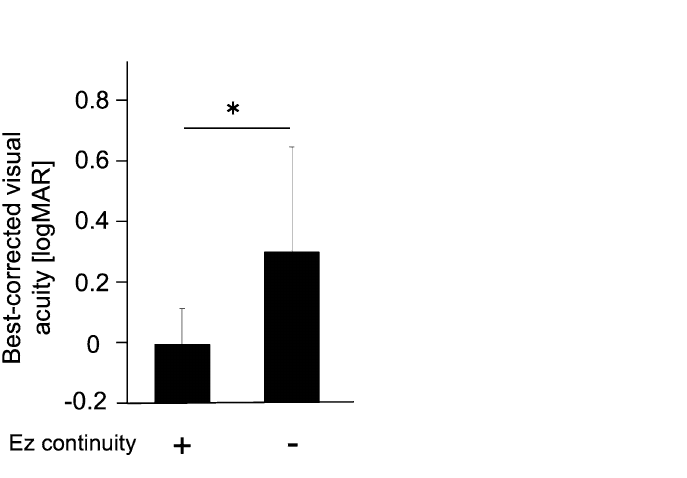
Figure 2. Relationship between the postoperative retinal structure and retinal sensitivity in eyes with rhegmatogenous retinal detachment. At both the fovea and perifovea, the postoperative retinal sensitivity is significantly better in the group with ellipsoid zone (Ez) continuity than in the group without Ez continuity. Eyes with postoperative subretinal fluid are excluded from this analysis. * P < 0.01; ** P < 0.001.